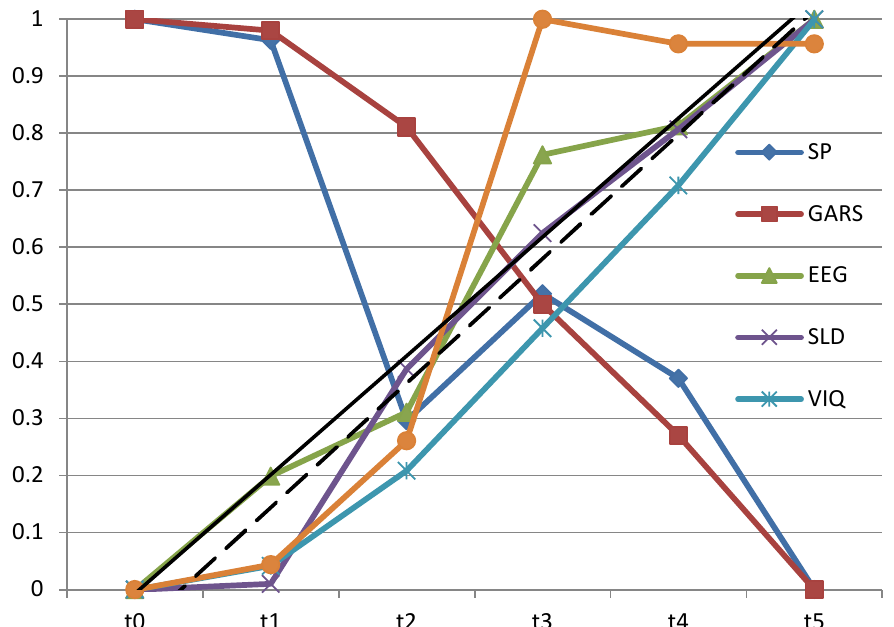
Figure 1. Comparison of the normalized achievement in all evaluation tests in all assessment points.